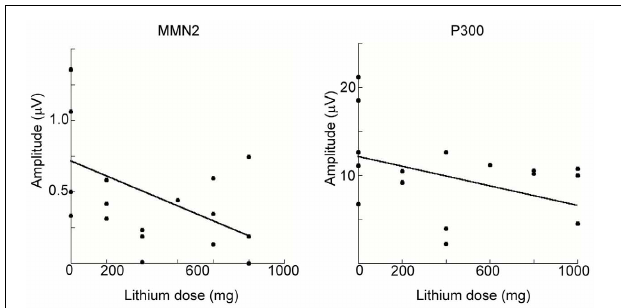
FIGURE 6 | Spearman’s rank correlation analysis for MMN2 (left) and P3 (right) as a function of lithium dosage within the BD patient group. In the both figures, MMN2 and P3 amplitude are smaller with increasing lithium